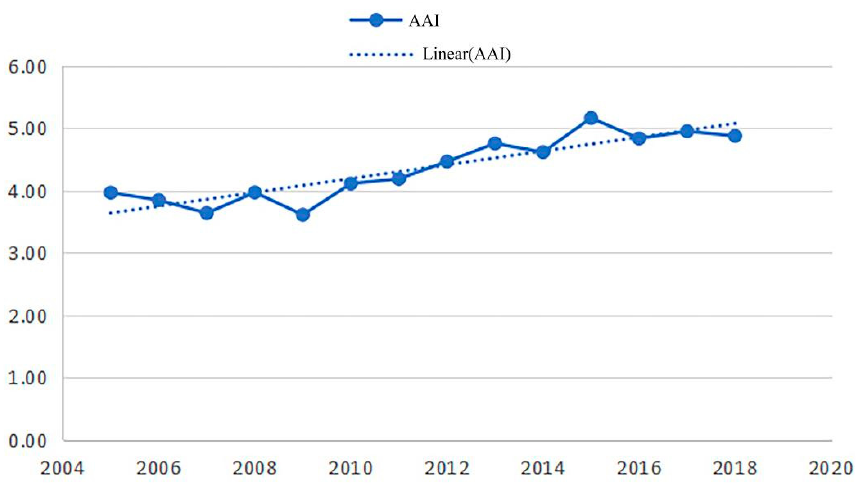
Figure 4. Xinjiang cotton production comprehensive comparative advantage (AAI).